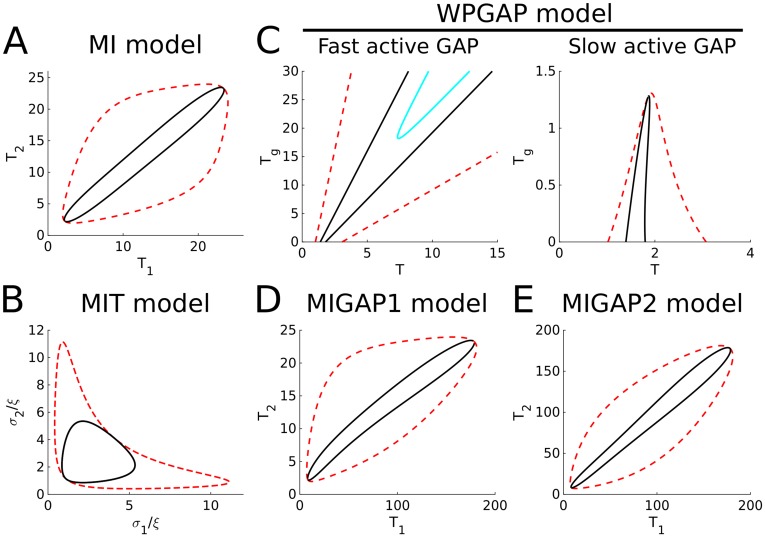
Two parameter bifurcation plots for LPA analyses on models with more than two variables.Default parameters were used. The bifurcation plot for the two ratios σ/ξ in the MIT model (B) appears to be the same regardless of the value of ξ1 = ξ2 = ξ (tested for ξ ∈ {0.05, 0.1, 0.2, 1}). For the WPGAP (C) model, the active GAP diffusion coefficient (DG) was considered both in the limit DG → ∞ (Fast active GAP) and in the limit DG → 0 (slow active GAP). Lines delimiting different regimes are coloured as in Fig 4. For the MI models with GAP feedback (D and E) we only considered fast active GAP.